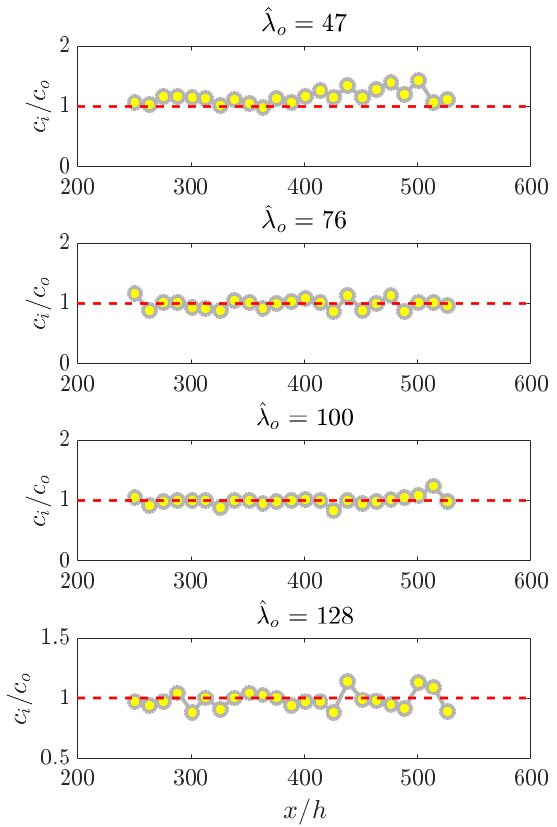
Figure 7. Recorded local phase speed at different points. The data found through computations are shown with the circle markers. The dashed red line is the reference line.